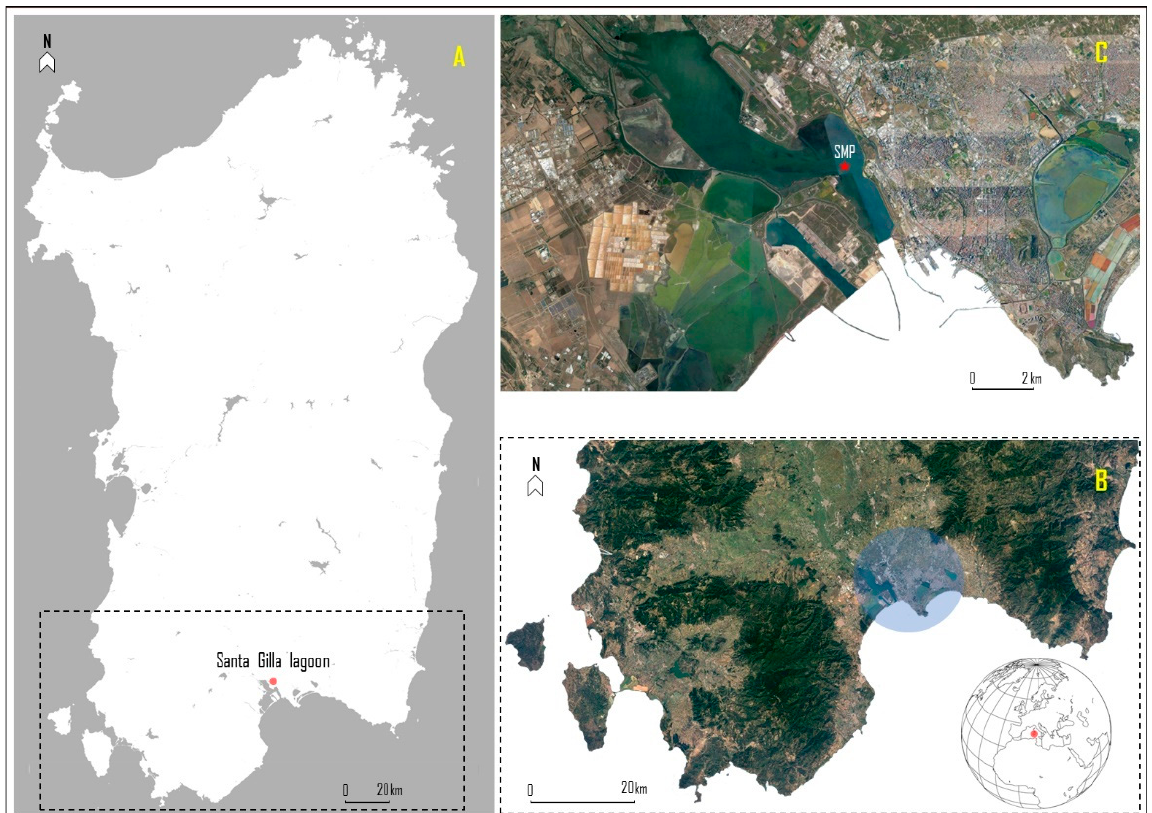
Figure 1. Study area: ( A ) = Sardinia Island, south of the sampling area; ( B ) = in the blue circle is identified the Santa Gilla lagoon; ( C ) = details of the lagoon, and sampling molluscs point (SMP; red star).